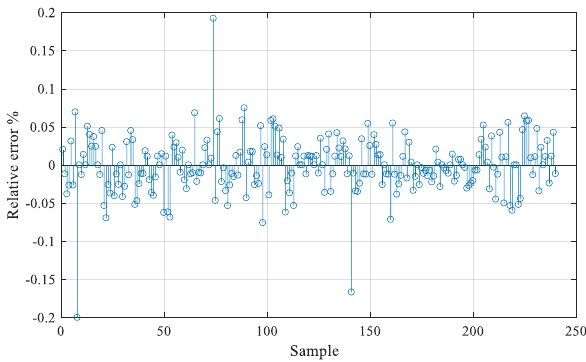
Figure 7. Tidal current direction prediction relative error.